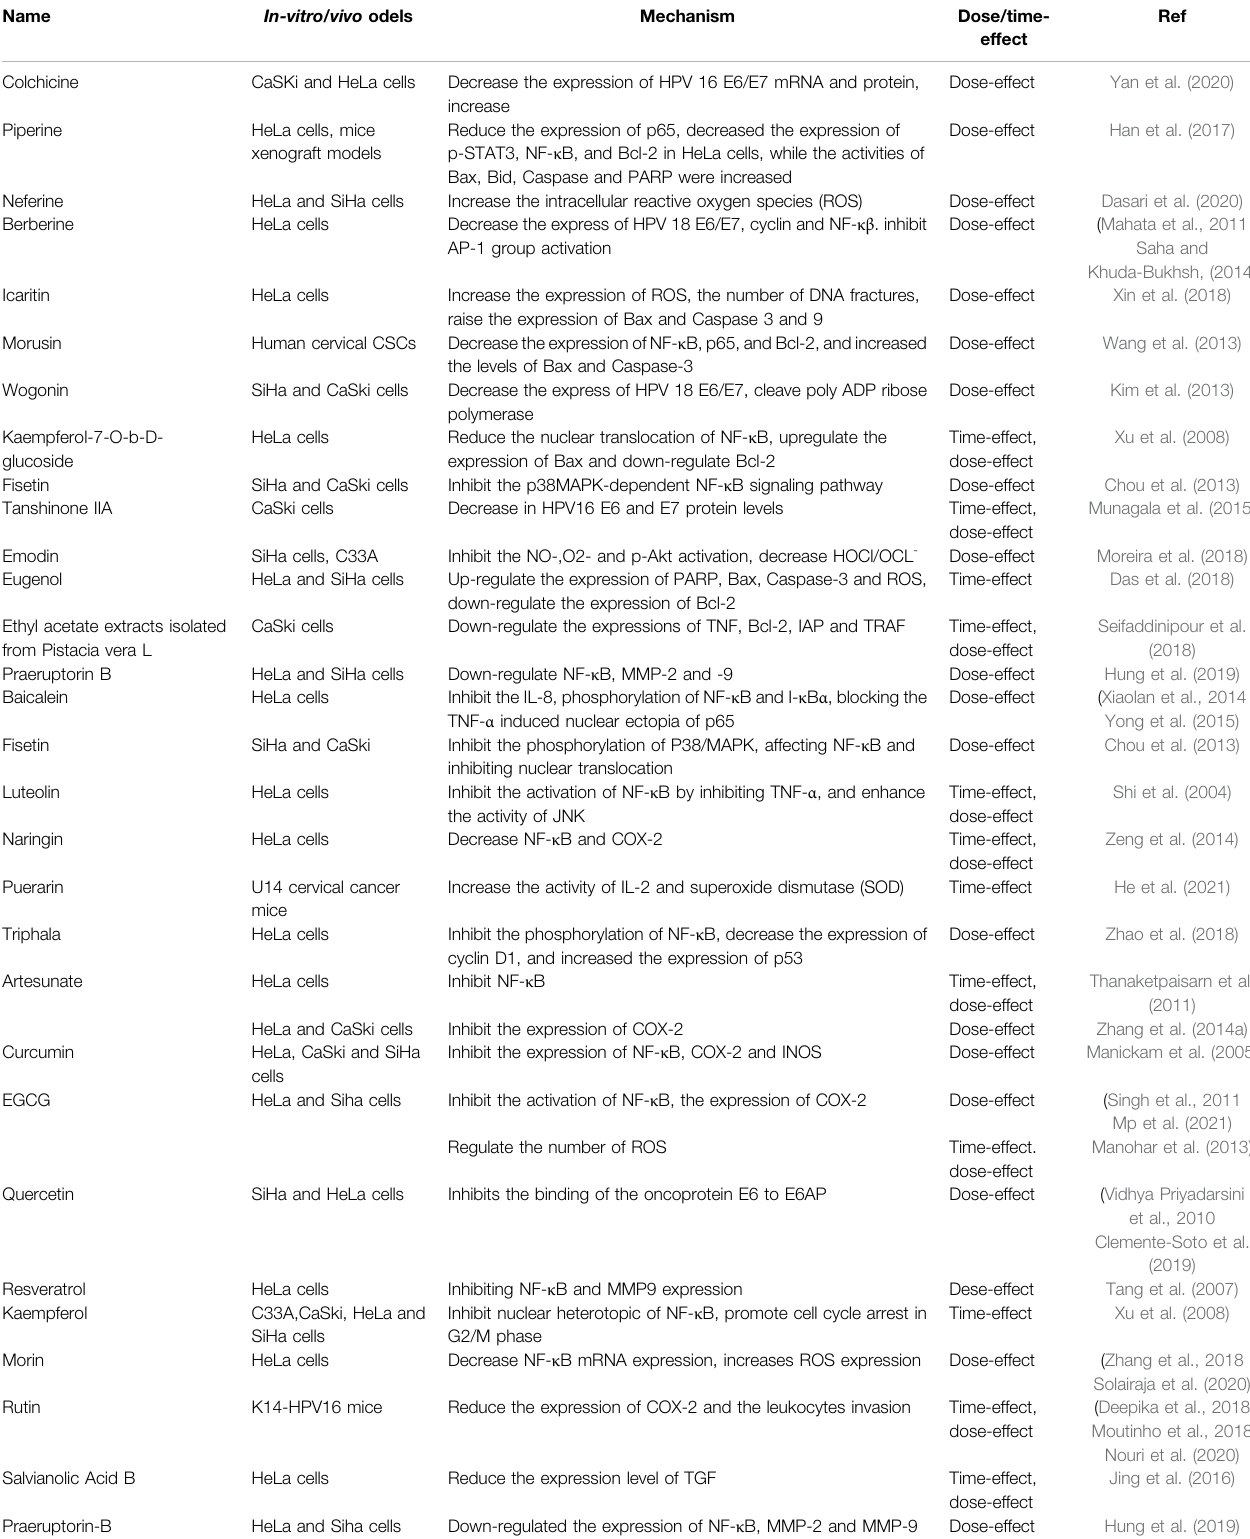
TABLE 1 | Therapeutic potential of natural products based on in fl ammation in cervical